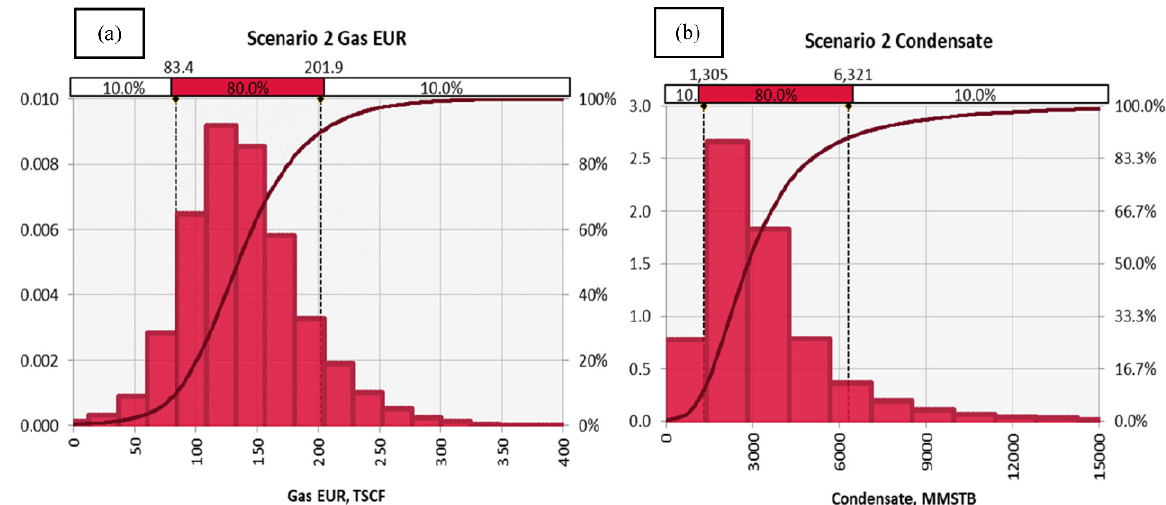
Figure 14. Scenario 2. Estimated ultimate recovery (EUR) of ( a ) gas EUR and ( b ) condensate.